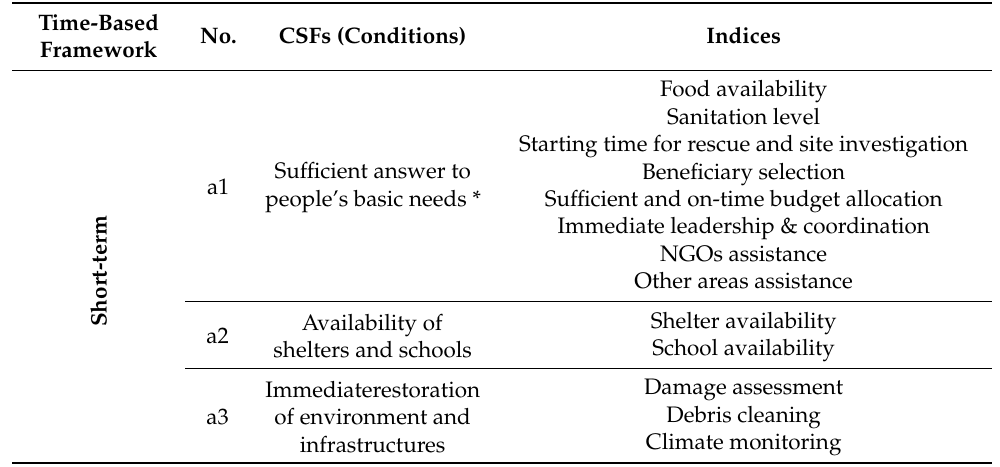
Table 4. Table of CSFs